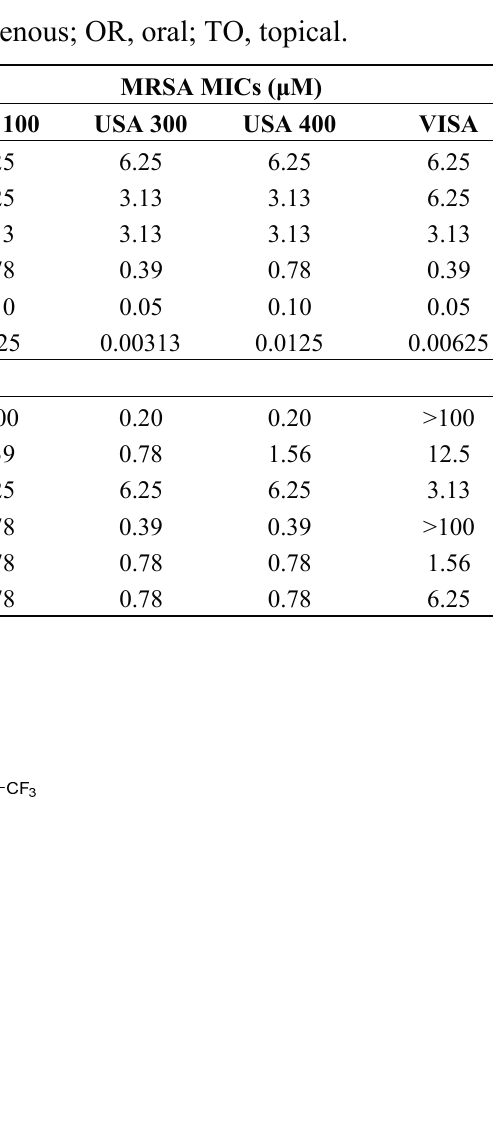
Figure 1. Drug structures with bioactivities against